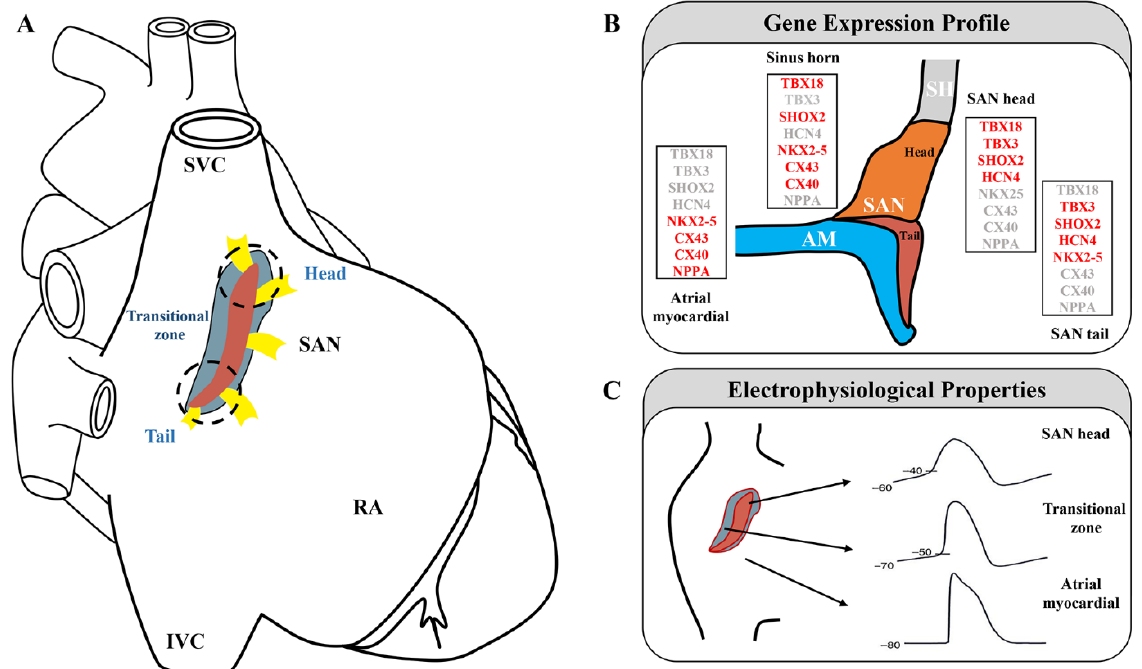
Figure 1. Sinoatrial node subdomains are divided based on anatomical and genetic criteria. ( A ) The sinoatrial node is displayed on a schematic diagram of the heart (red, central SAN region; blue, transitional cells; yellow, sinoatrial conduction pathways; white dashed line, SAN head; black dashed line, SAN tail). Adapted with permission from [26,30], Copyright (2005, 2017). ( B ) Gene expression profile in the SAN region (expressed genes are indicated in red). Adapted with permission from [7], Copyright (2009). ( C ) Samples of action potentials (APs) are recorded from the central sinoatrial node to the periphery of the node. Adapted with permission from [22], Copyright (2016).